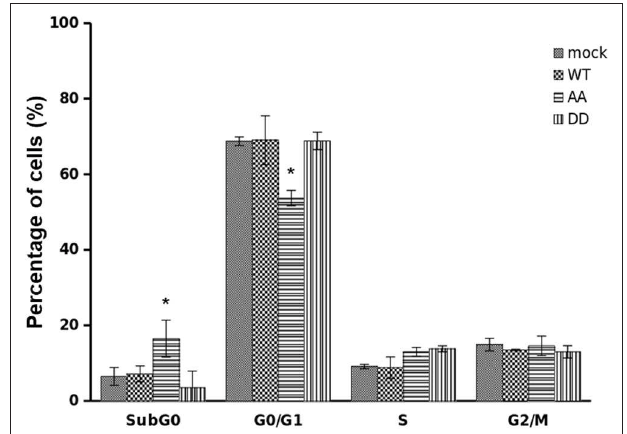
FIGURE 5 | Biphospho-resistant ECE1c AA expression impinges progression through G1 and sensitizes CRC cells to death by 5-fluorouracil. DLD-1 cells overexpressing Flag-tagged ECE1c WT , ECE1c AA , ECE1c DD proteins, or mock-transduced cells were grown for 24h in the presence of 25 µ M 5-fluorouracil (5-FU) and cell cycle analysis was performed by flow cytometry. Graph represents mean ± SEM; * p <